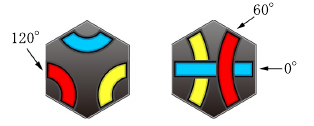
Figure 5. Three angles of